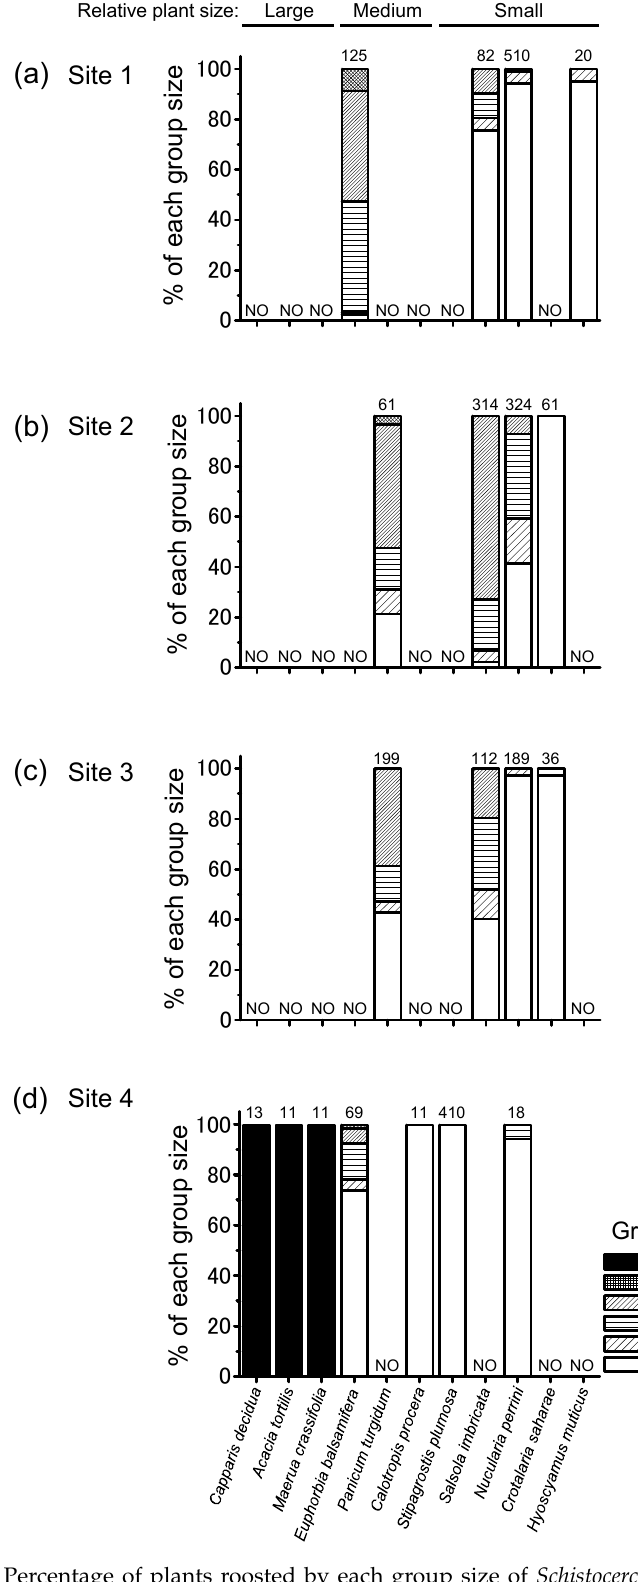
Figure 5. Percentage of plants roosted by each group size of Schistocerca gregaria swarms for the 11 dominant plant species at the four study sites [Site 1: ( a ), Site 2: ( b ), Site 3: ( c ), and Site 4: ( d )]. Numbers above bars indicate sample sizes (numbers of plants observed). “NO” in the figures indicates absence of the plant species at the study site.